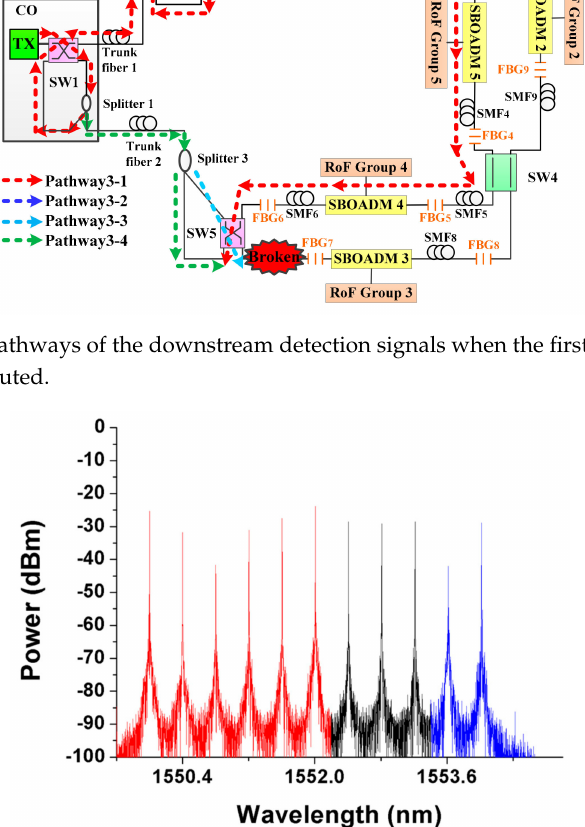
Figure 12. Detection signals received by the CO during the execution of the first phase of the second detection